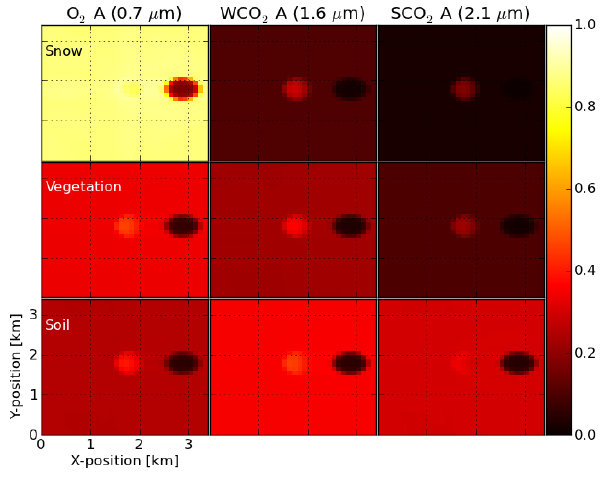
Figure 3. Overhead views of the scene reflectance as simulated by SHDOM, for a channel within each OCO-2 band that has relatively low gas absorption. Each of the three columns shows the reflectance for one of the three OCO-2 bands, and each of the three rows shows reflectance from one surface type. All images are shown with the same display scale, to highlight the differences in contrast between the cloud and surface for the different spectral bands and surface